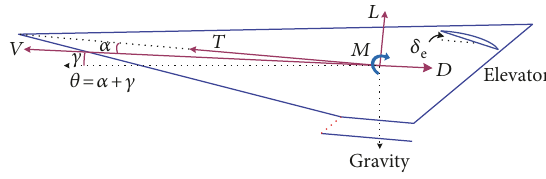
Figure 1: The geometry and force map of an